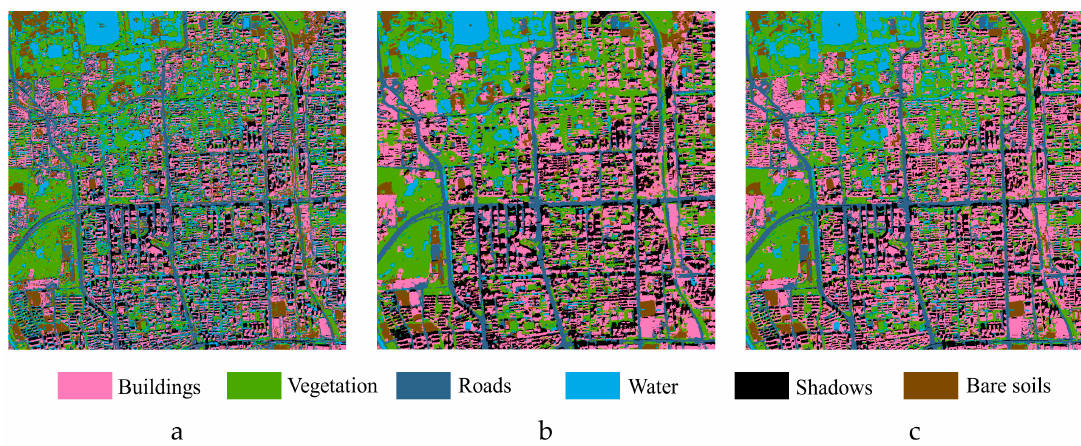
Figure 18. Classification results of different features combinations. ( a ) Classification result with object features; ( b ) classification result with object features; ( c ) classification result with both object and deep features.